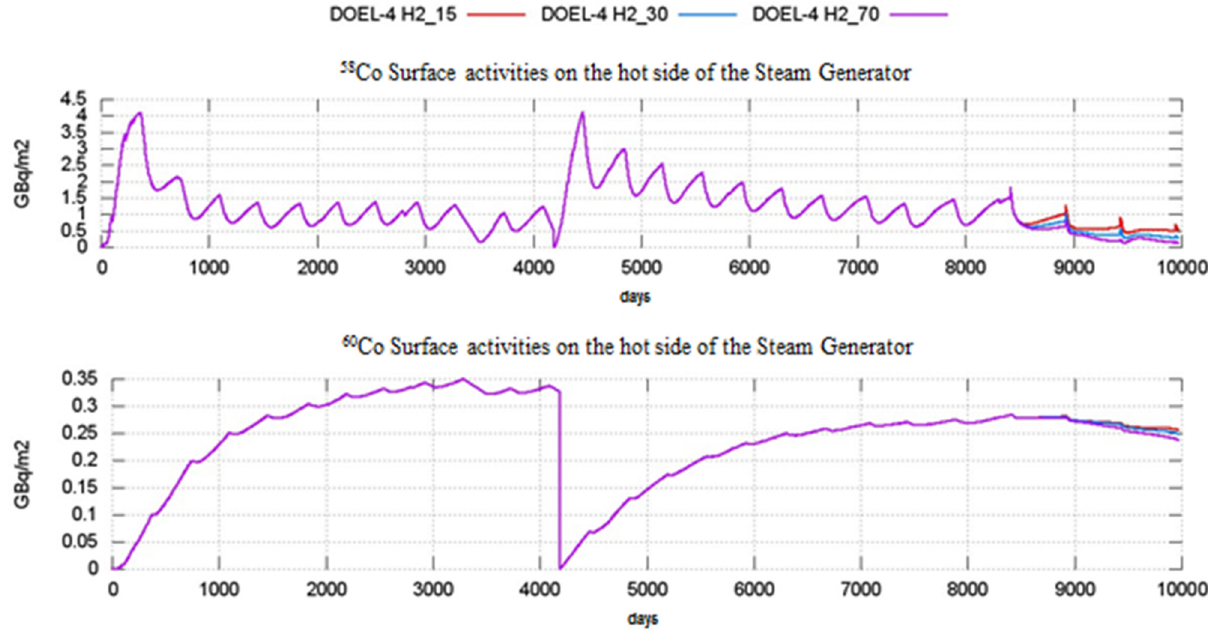
Fig. 6. OSCAR V1.3 calculation (cid:2) Surface activities on the hot side of the steam generator tubing region of DOEL-4.